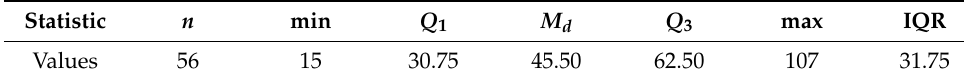
Table 5. Descriptive statistics for the COVID-19 data set of Senegal.